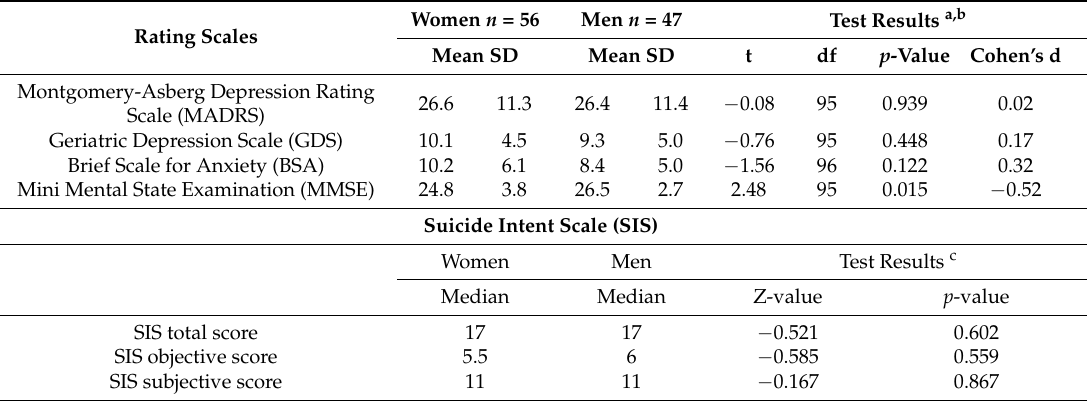
Table 3. Results of analyses for rating scales in hospitalized suicide attempters aged 70 and above, by